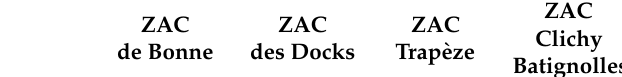
Table 15. The assessment grid. Source: Authors’ elaboration (2022) from the analysis of the 4 case studies, data based on http://www.ecoquartiers.logement.gouv.fr and on survey/on-site visit (accessed on 19 June